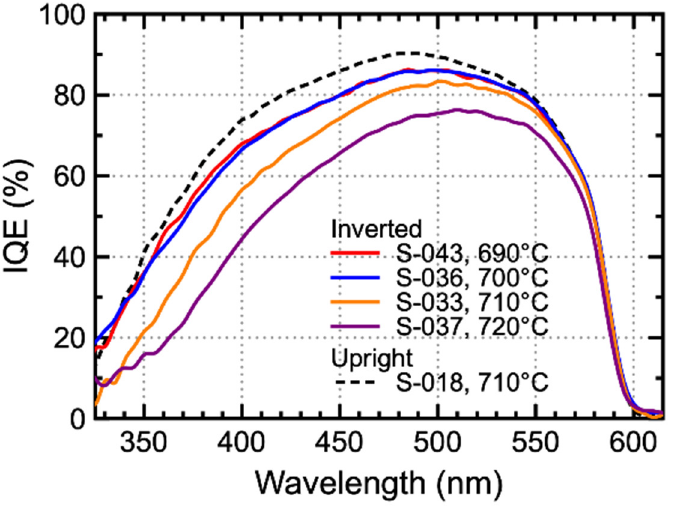
Figure 3. IQE curves of inverted 2.1 eV AlGaInP sub-cells grown at different temperatures (690 °C–720 °C, solid line), showing that higher temperature reduces carrier collection efficiency. Upright 2.1 eV AlGaInP sub-cell grown at 710 °C is set as benchmark (dashed line). Table 1. Light J–V results of dual-junction solar cells (S-018, S-043, S-036, S-033 and S-037). No. Temp. (°C) Jsc (mA)